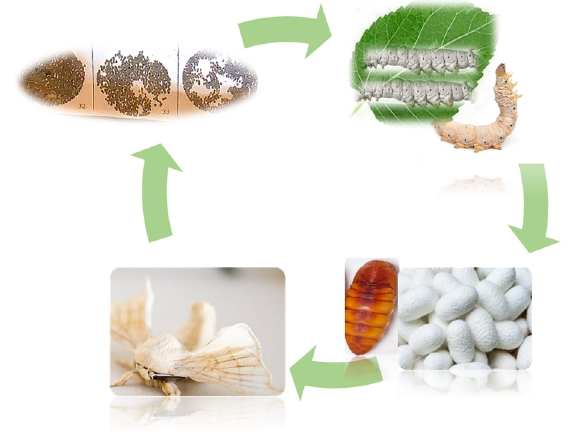
Figure 1. The life cycle of silkworm B . mori